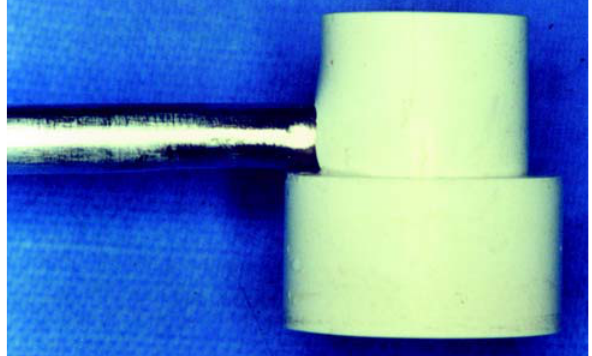
FIGURE 3- Gnathodynamometer used for bite force measurement. This equipment consists of a 10 mm high x 10mm diameter stainless steel cylinder enclosing two strain gauge sensors